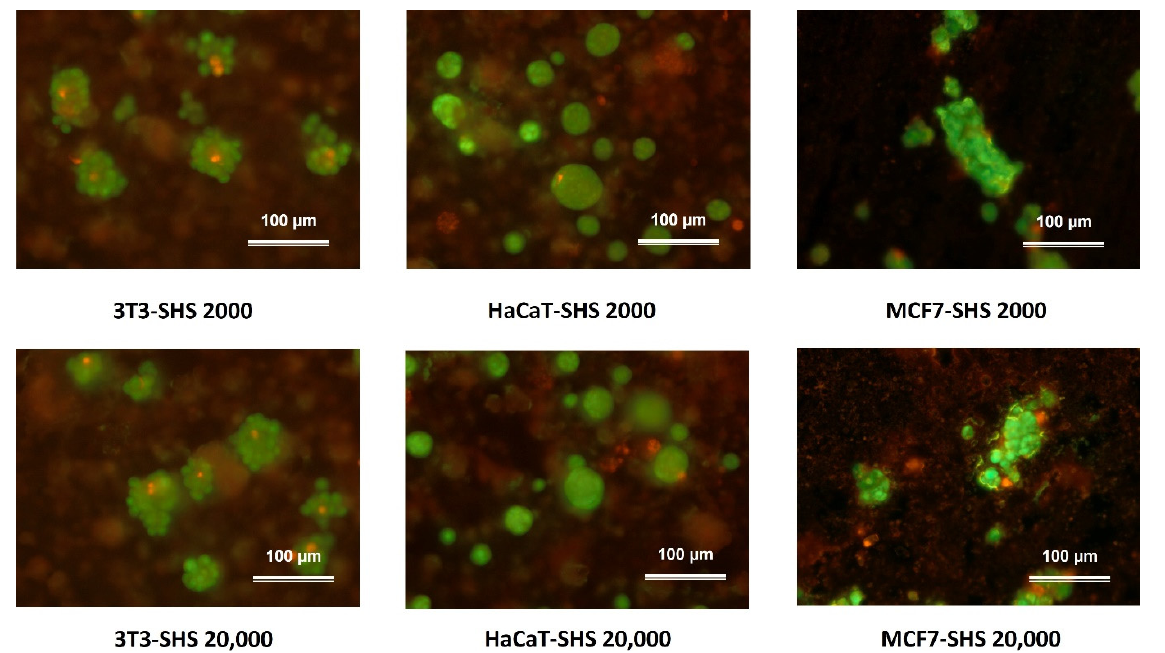
Figure 5. Representative fluorescence microscopy images of spheroids as a function of the initial cell density (either 2000 cell/µL or 20,000 cell/µL) after incubation in the SH coating after 24 h. Green fluorescence indicates AO stain in the live cells and red fluorescence indicates the EtBr stain in the dead cells. Scale bars represent 100 µm.